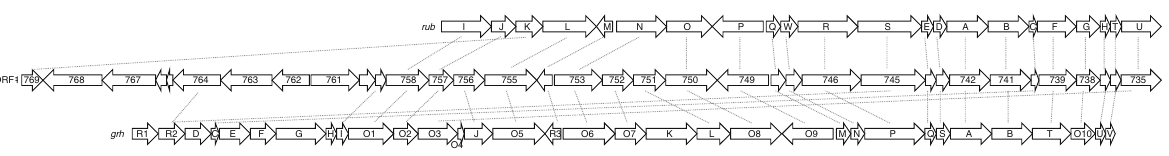
Fig. 3 Gene organizations of rubromycin-, hyarulomycin- and griseorhodin-biosynthetic gene clusters. Homologs are linked by gray dotted lines. The rub , Orf1- and grh are rubromycin-, hyarulomycin- and griseorhodin-biosynthetic gene clusters, respectively. Hyarulomycin-biosynthetic genes are indicated with orf numbers as shown in Table